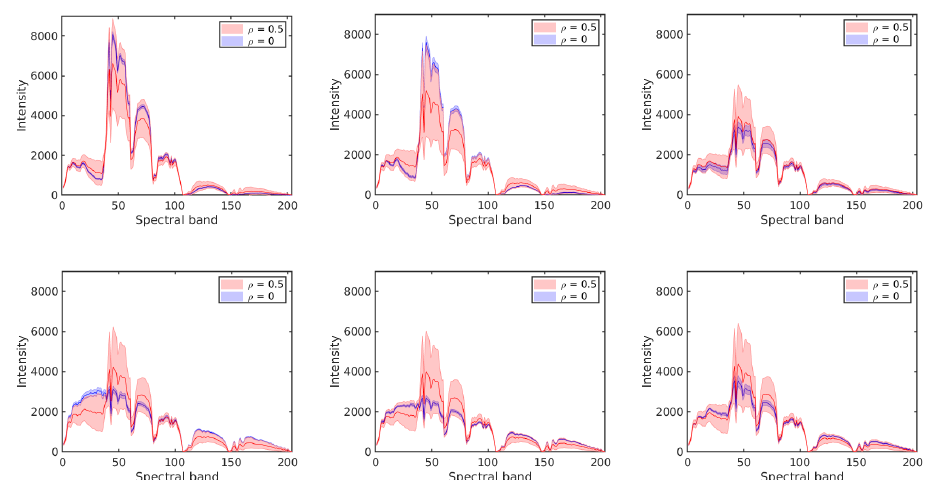
Figure 6. Spectral signatures for Class 1–6 (from top left to bottom right) with different levels of label noise for the Salinas Scene data